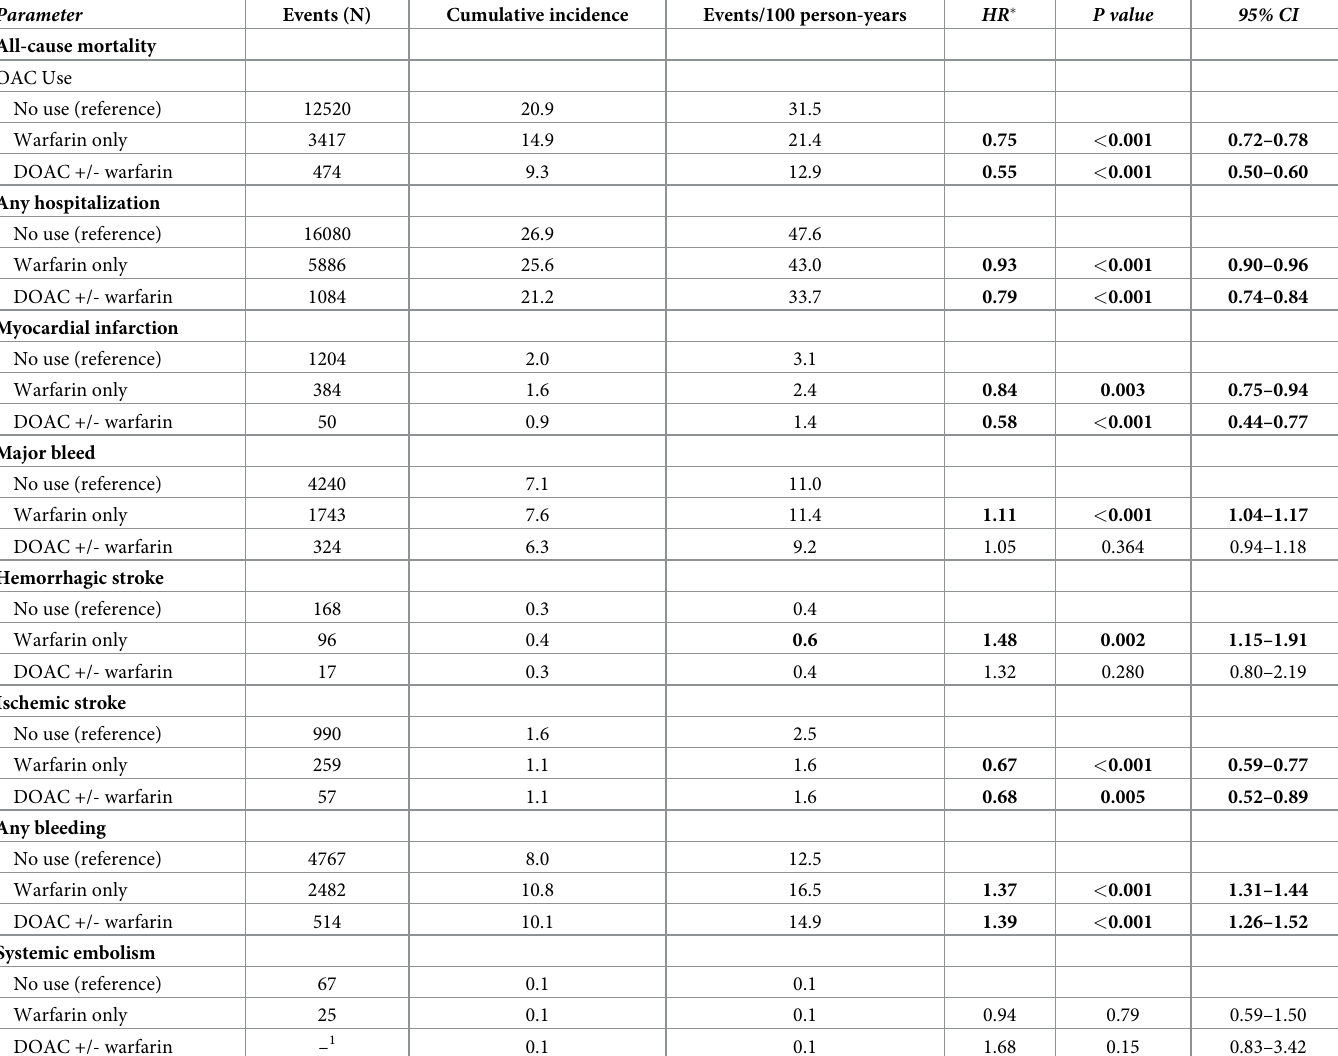
Table 4. Observed clinical event cumulative incidence, incidence per 100 person-years and multivariate adjusted hazard ratios for the association between OAC use in the 3 months post-NVAF diagnosis and adverse events occurring in the period from 3 months to 12 months post-diagnosis for patients enrolled in Medicare Part D (N =